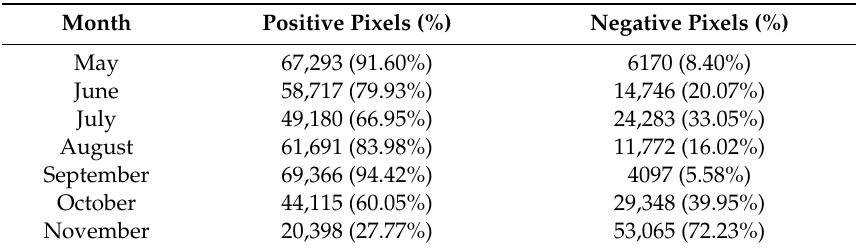
Table 2. The number of pixels and their proportions of correlation coe ffi cients between monthly precipitation and CUE.